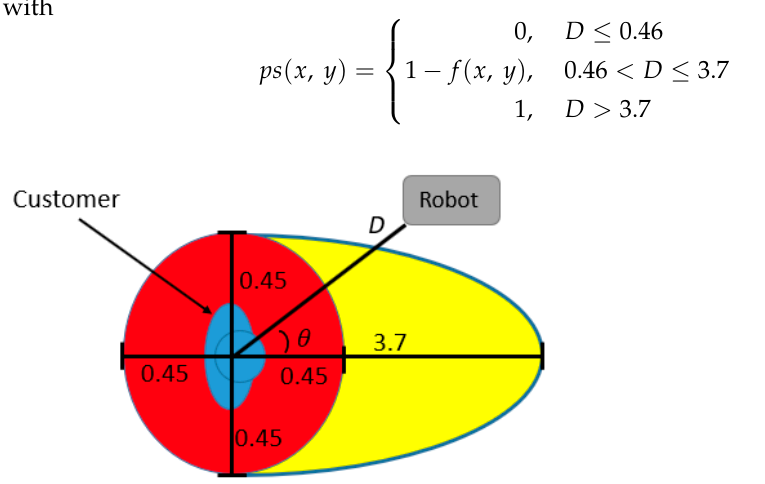
Figure 4. Illustration of the personal space.